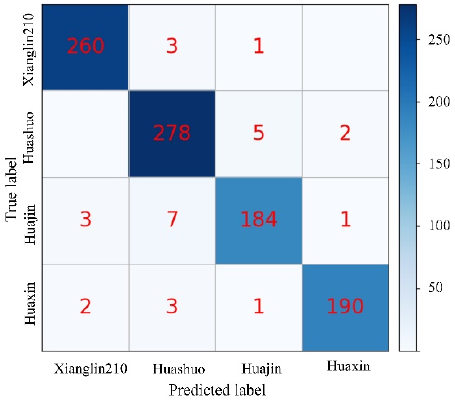
Figure 5. Confusion matrix of EfficientNet-B4-CBAM.